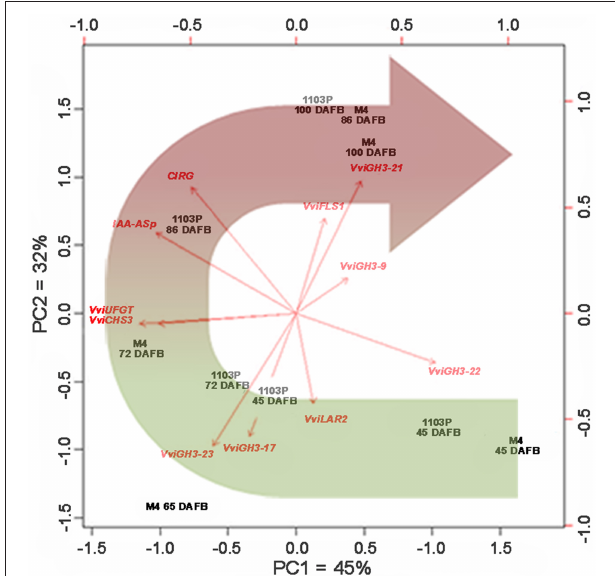
FIGURE 8 | CS/M4 and CS/1103P samples distribution according to a PCA analysis carried out on VvGH3s and flavonoid-related qRT-PCR data, and colorimetric parameters (CIRG index). Percent of variance for each component on the corresponding axes and effect of considered parameters on samples distribution (red arrows) are also